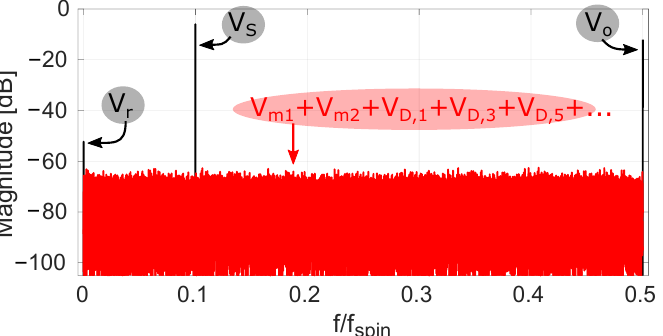
Figure 6. Simulated spectrum with a − 6dBfs input sine wave at frequency 0.1 f spin for V S . Offset tones, corresponding to randomized four-phase spinning, are present with magnitudes based on our measurements.